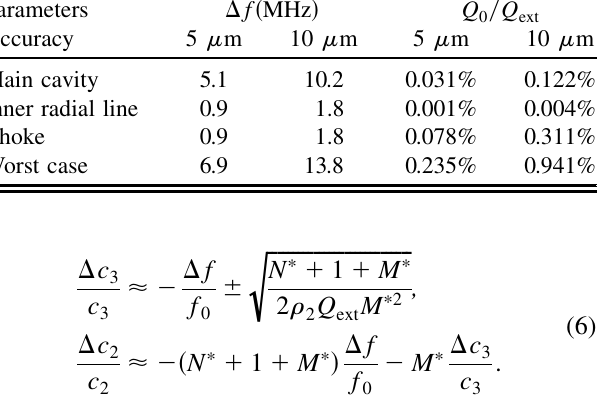
TABLE I. Change of frequency and Q factor in different machining accuracies, Q 0 =Q ext ¼ (cid:3) (cid:1) Q=Q is the Q decrease, with the assumption that Q 0 (cid:2) 5000